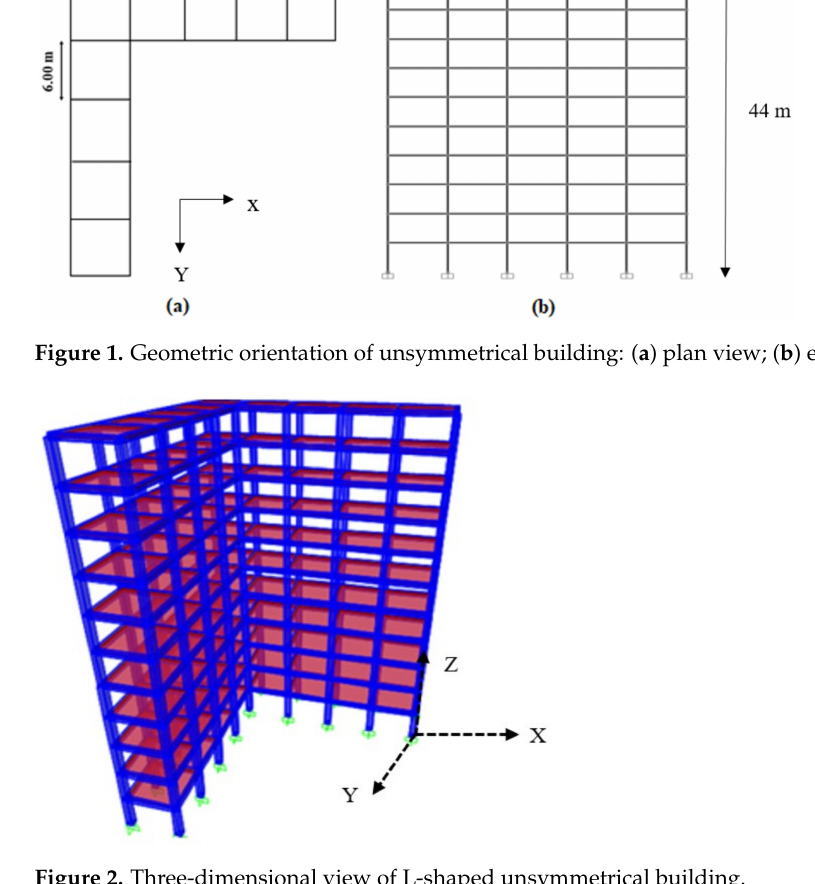
Figure 2. Three-dimensional view of L-shaped unsymmetrical building.